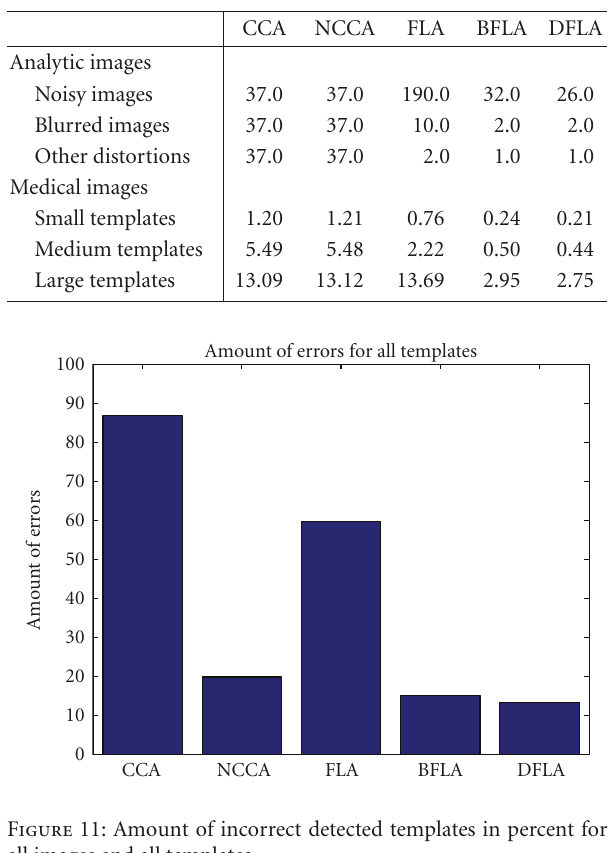
Table 1: Computation e ff ort of the cross-correlation algorithms in seconds per image for the di ff erent analytic test images and the hu- man retinal images.